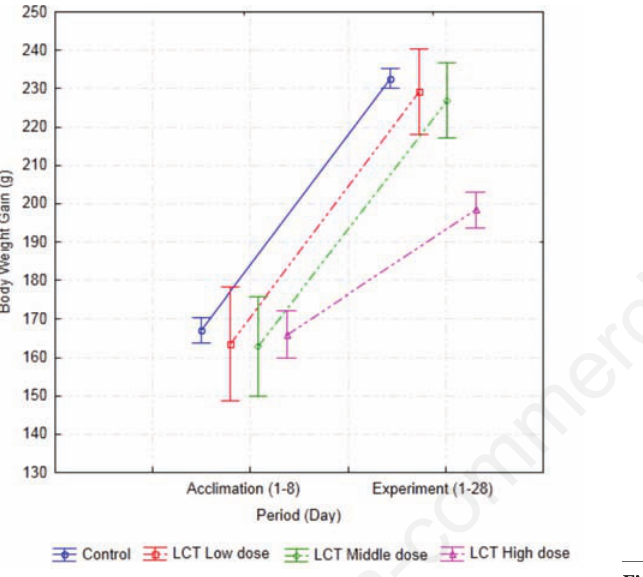
Figure 3. Plasma lambda-cyhalothrin (LCT) cyhalothrin (1) and Figure 2. Effect of lambda-cyhalothrin (LCT) on body weight of cyhalothrin (2) concentrations (ng/g) obtained at 28 days after N rats, throughout the acclimation (1-8 days) and experimental (1- administration of three doses of LCT (20.4, 30.6 and 61.2 mg/kg 28 days) periods. b.w.) daily for 28 days to male rats. Mean (±SD) (n=7).